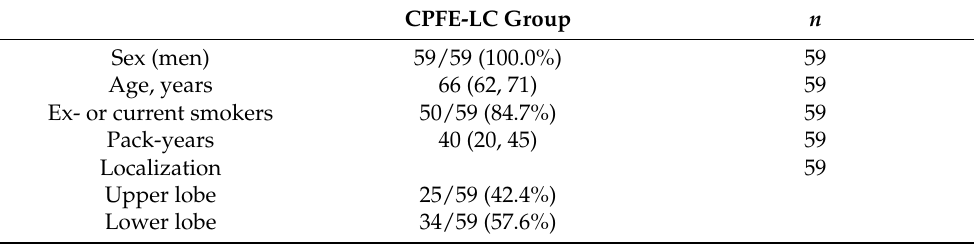
Table 1. Baseline clinical characteristics and tumor features of lung cancer patients with